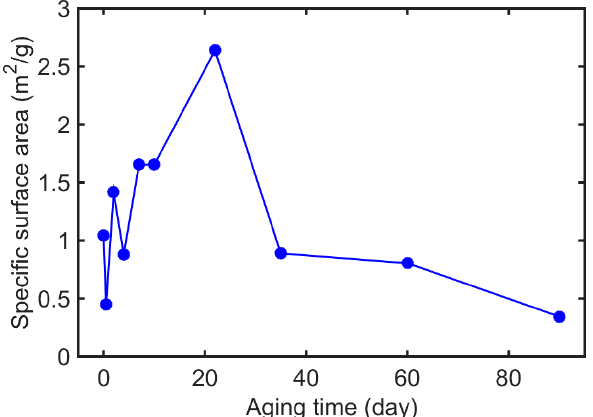
Figure 13. Specific surface area of paper thermally aged for various durations at 130 °C.